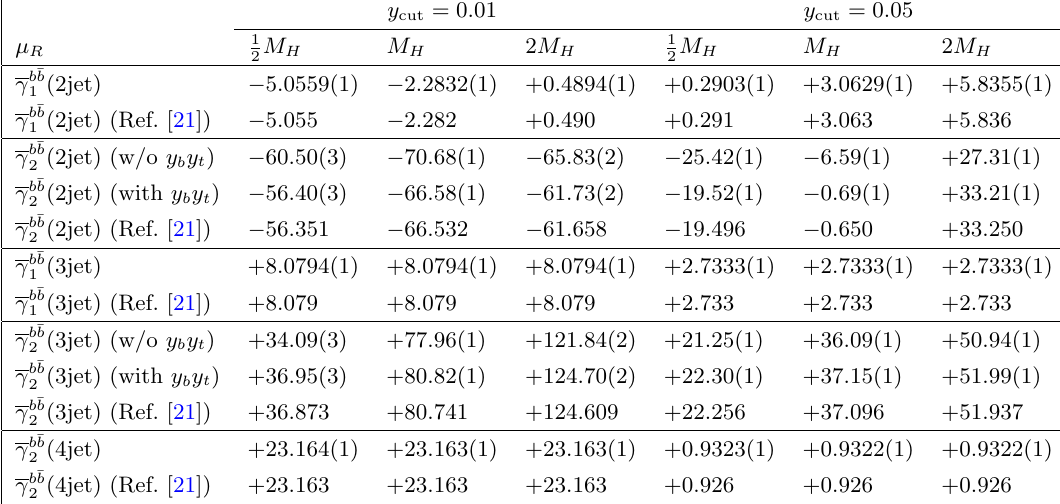
Table 4. The jet rates expansion coe(cid:14)cients (cid:13) b (cid:22) b (obs) as de(cid:12)ned in eq. (5.7) and computed using i the Durham clustering algorithm with y cut = 0 : 01 and y cut = 0 : 05 for various choices of the renor- malisation scale. Whenever necessary, we report results without and with top-quark